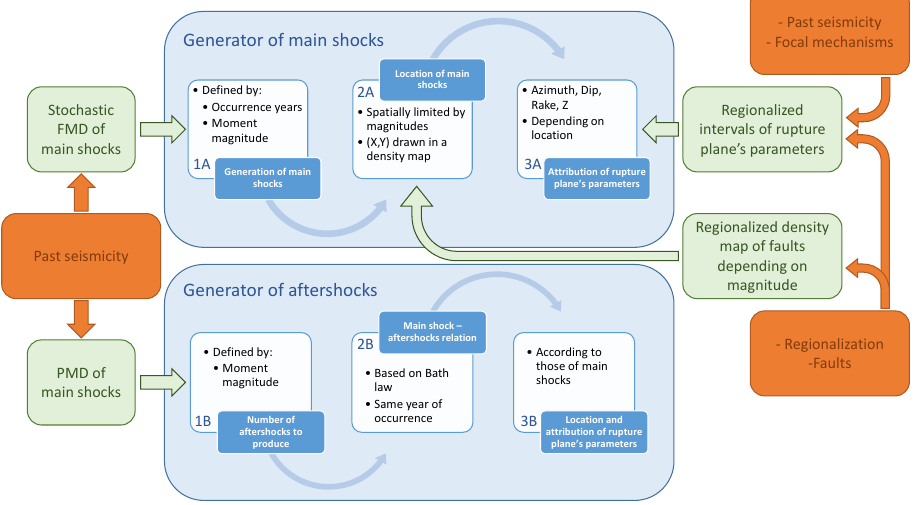
Figure 1. General workflow of earthquake generation. Blue: generator. Green: generator’s inputs. Orange: data. FMD: Frequency–Magnitude Distribution. PMD: Proportion–Magnitude